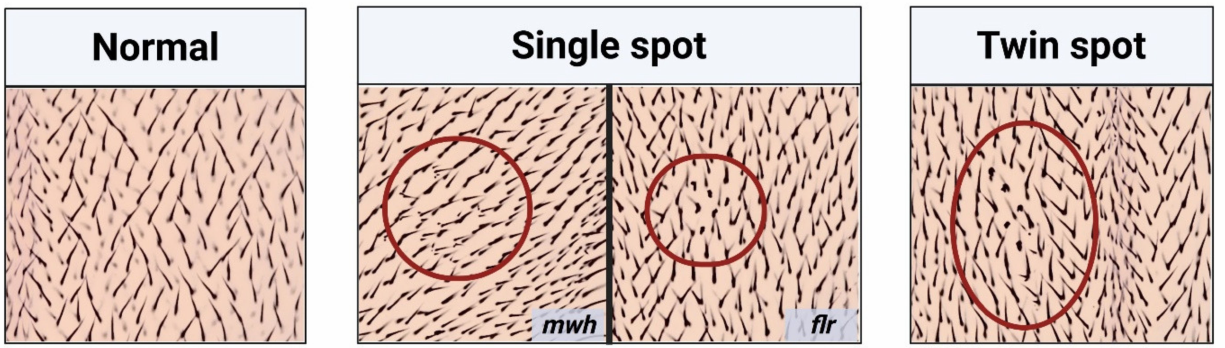
Figure 2. Characteristics observed on the Drosophila wings. (Left) Characteristics of normal wing spots (each hair in the adult wing is the result of the cuticular secretion of each wing disc cell); (Middle and Right) characteristics of mutant wing spots (single spots (middle panel) and twin spots (right panel)), which can be induced by genotoxins. mwh — multiple wing hairs, and flr